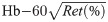
Part A of the Study.Individual blood OFF-hr score. Results from analysis of 161 blood samples from transfused men (N = 11, Nr 1–17) in Panel A, and in Panel B 93 samples from control men (N = 7, Nr 9–19). All samples were taken in parallel during 22 weeks (Fig 1). Transfused subjects donated two units (900 mL) blood and were re-infused with the washed, cryo-preserved RBC fraction at week 17 (Fig 1). Control subjects were sampled and tested at the same time intervals, except one hour before and after the RBC reinfusion. For reference, a dashed black line at OFF-hr = 129 (OFF-hr = Hb-60Ret(%)) is one suggested limits for indication of blood doping with EPO [47] but used by others for investigation of blood manipulation in general.